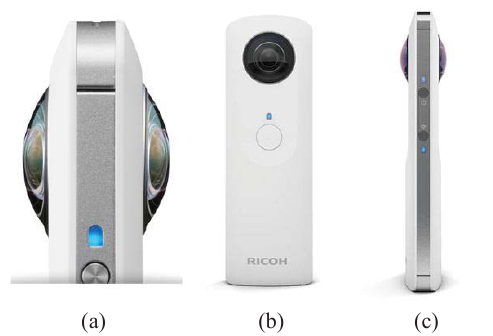
Figure 1. Ricoh-Theta Camera. (a) Magnification of the two fisheye lenses in side view, (b) cameras front view and (c) side view.